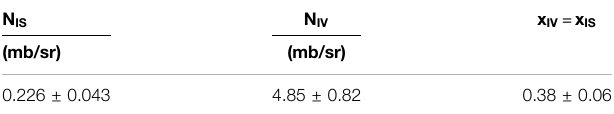
TABLE3| EmpiricallydeterminedUCSparametersfromthe fi tshownin Figure4